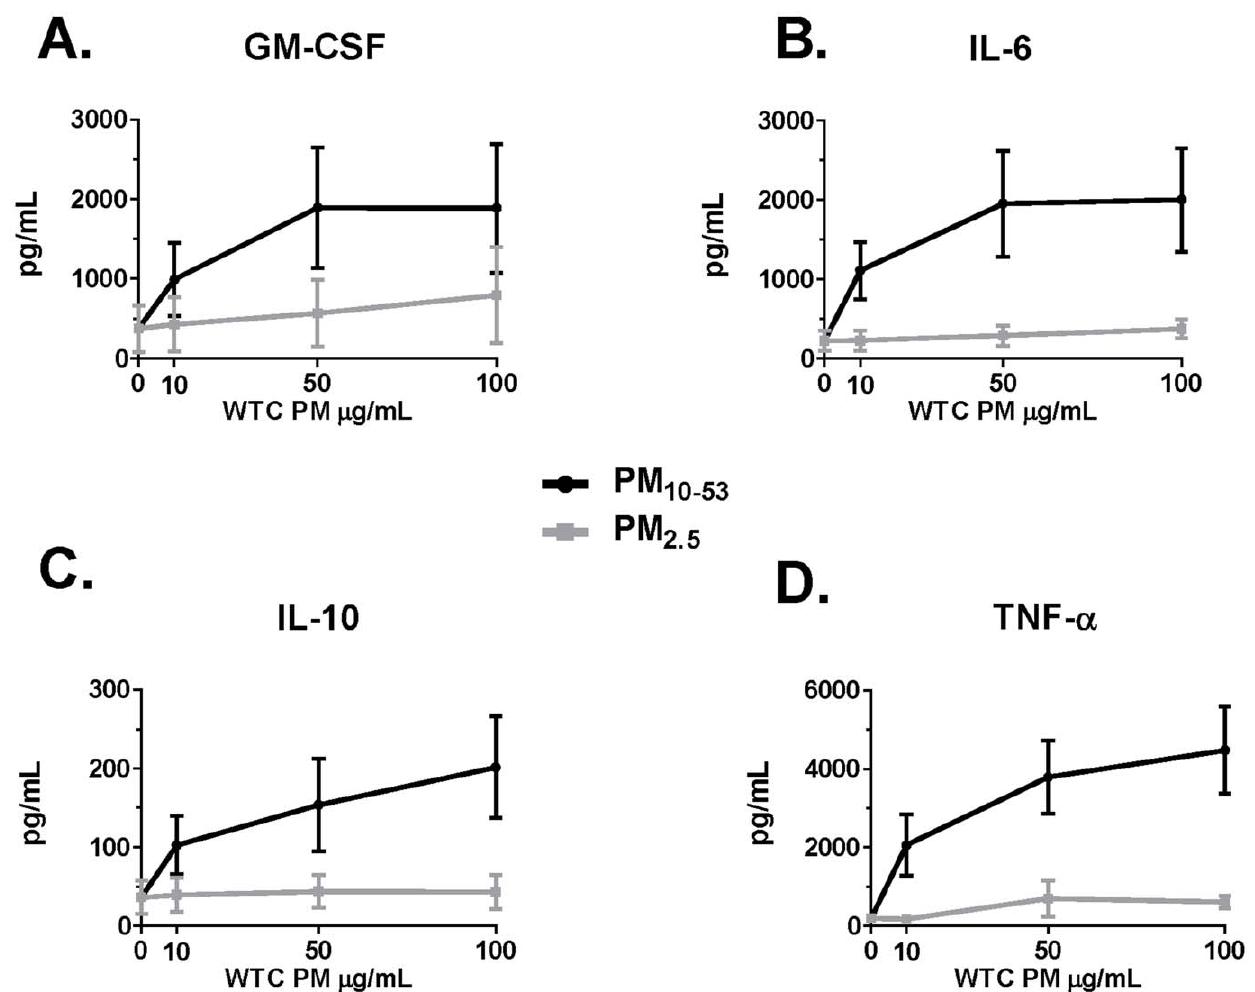
Figure 1. Cytokine expression by Alveolar Macrophages 24 hours after stimulation with increasing doses of WTC-PM 2.5 and WTC- PM 10–53 in m g/ml. All cytokines with a $ 2-fold induction of PM 10–53 /PM 2.5 at each dose are shown. All graphs show mean 6 SEM of cytokine, p , 0.01 for all comparisons between PM 10–53 and PM 2.5 by Wilcoxon Matched Pairs Signed Rank Test. Panel A) GM-CSF B) IL-6 C) IL-10 D) TNF- a . N=14 for WTC-PM 2.5 and WTC-PM 10–53 at 10 m g/mL; N=15 for all other exposures. Figure 2D. To test if segregation of MDC and GM-CSF expression in serum is due to selection bias produced by the case definition we repeated the hierarchical clustering using serum of control subjects. There was no difference analyte clustering in cases and controls, Figure 2E.